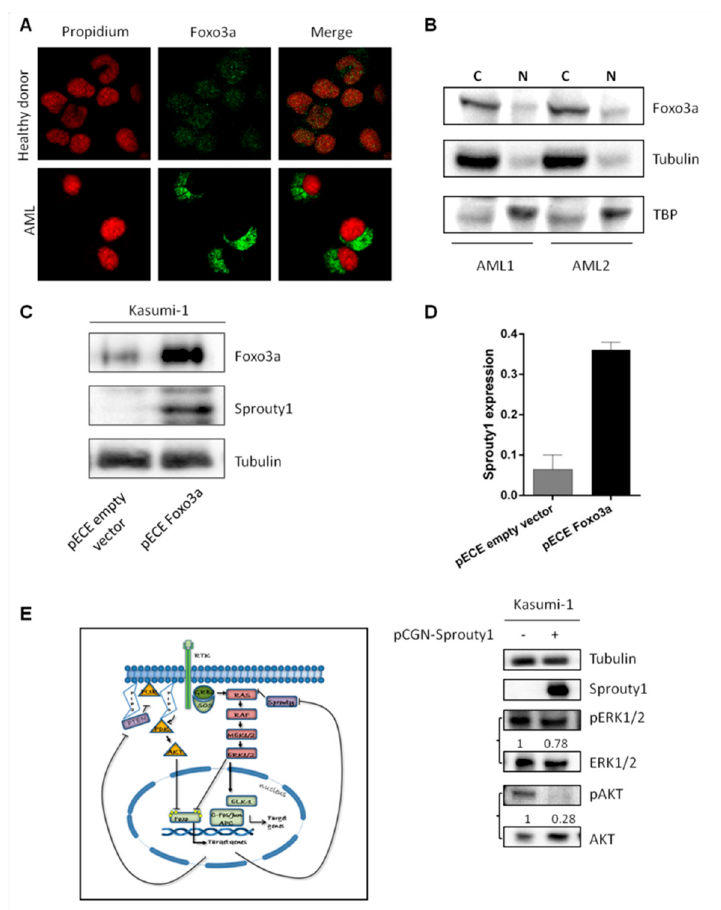
Figure 3. ( A ) Immunofluorescence staining performed with anti-FoxO3a (green signal) on cells derived from control subjects and AML patients at diagnosis. ( B ) Western blot performed with an antibody against FoxO3a on lysates derived from the cytosolic and nuclear fraction of AML patients. ( C ) Western blot of FoxO3a and Sprouty1 in Kasumi-1 cells transfected with FoxO3a or empty plasmids. ( D ) Sprouty1 gene expression analysis on Kasumi-1 cells transfected with FoxO3a or empty plasmids. The quantity is expressed as 2 - ∆∆ Ct after normalization with Abl housekeeping gene. ( E ) Schematic representation of RAS / PI3K pathways and their negative regulation on FoxO3a. Representative western blot showing Sprouty1-dependent regulation of the RAS pathway in Kasumi-1 cells transfected with Sprouty1 plasmid. The relative intensity of each band is shown under the blot as fold change compared to non-transfected control, to which a value of 1 unit was assigned.